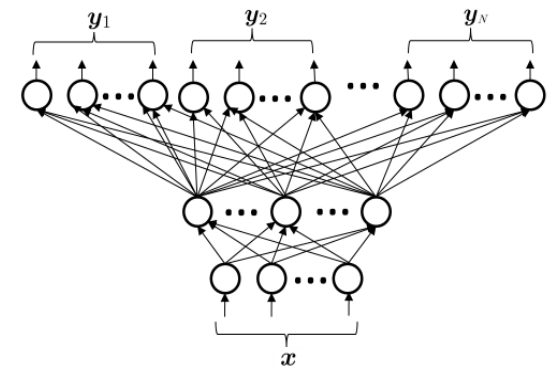
FIGURE 2. mNN inverse modeling towards accurate and efficient antenna array